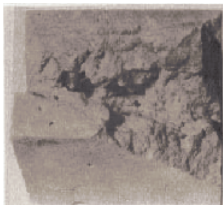
Fig. 1. Sample of dolomite exposed to cavitation [2].